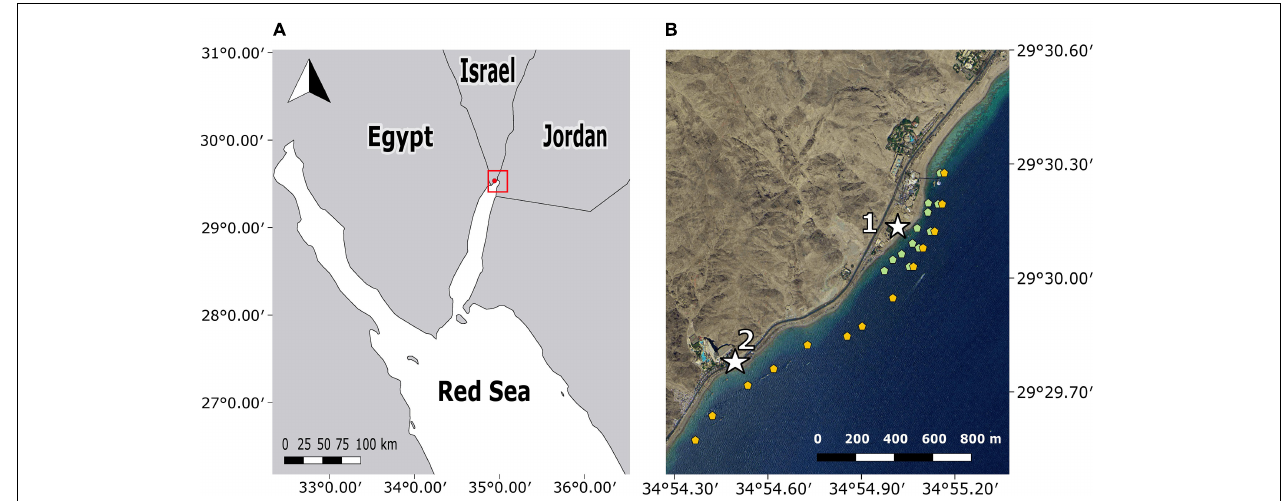
FIGURE 1 | Map of the study area located in the northern tip of the Gulf of Aqaba. (A) Regional map of the Red Sea with the study site marked in red. (B) Receiver locations, Vemco receivers marked in orange, and Thelma Biotel receivers marked in green. The two capture sites are indicated as white stars. Site 1 is The Interuniversity Institute for Marine Sciences (IUI), site 2 is the southern beach